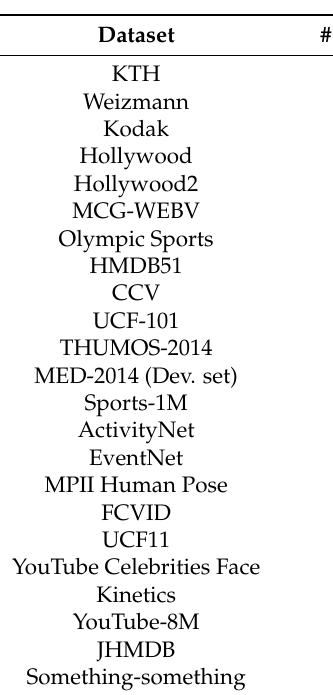
Table 4. Benchmark datasets.